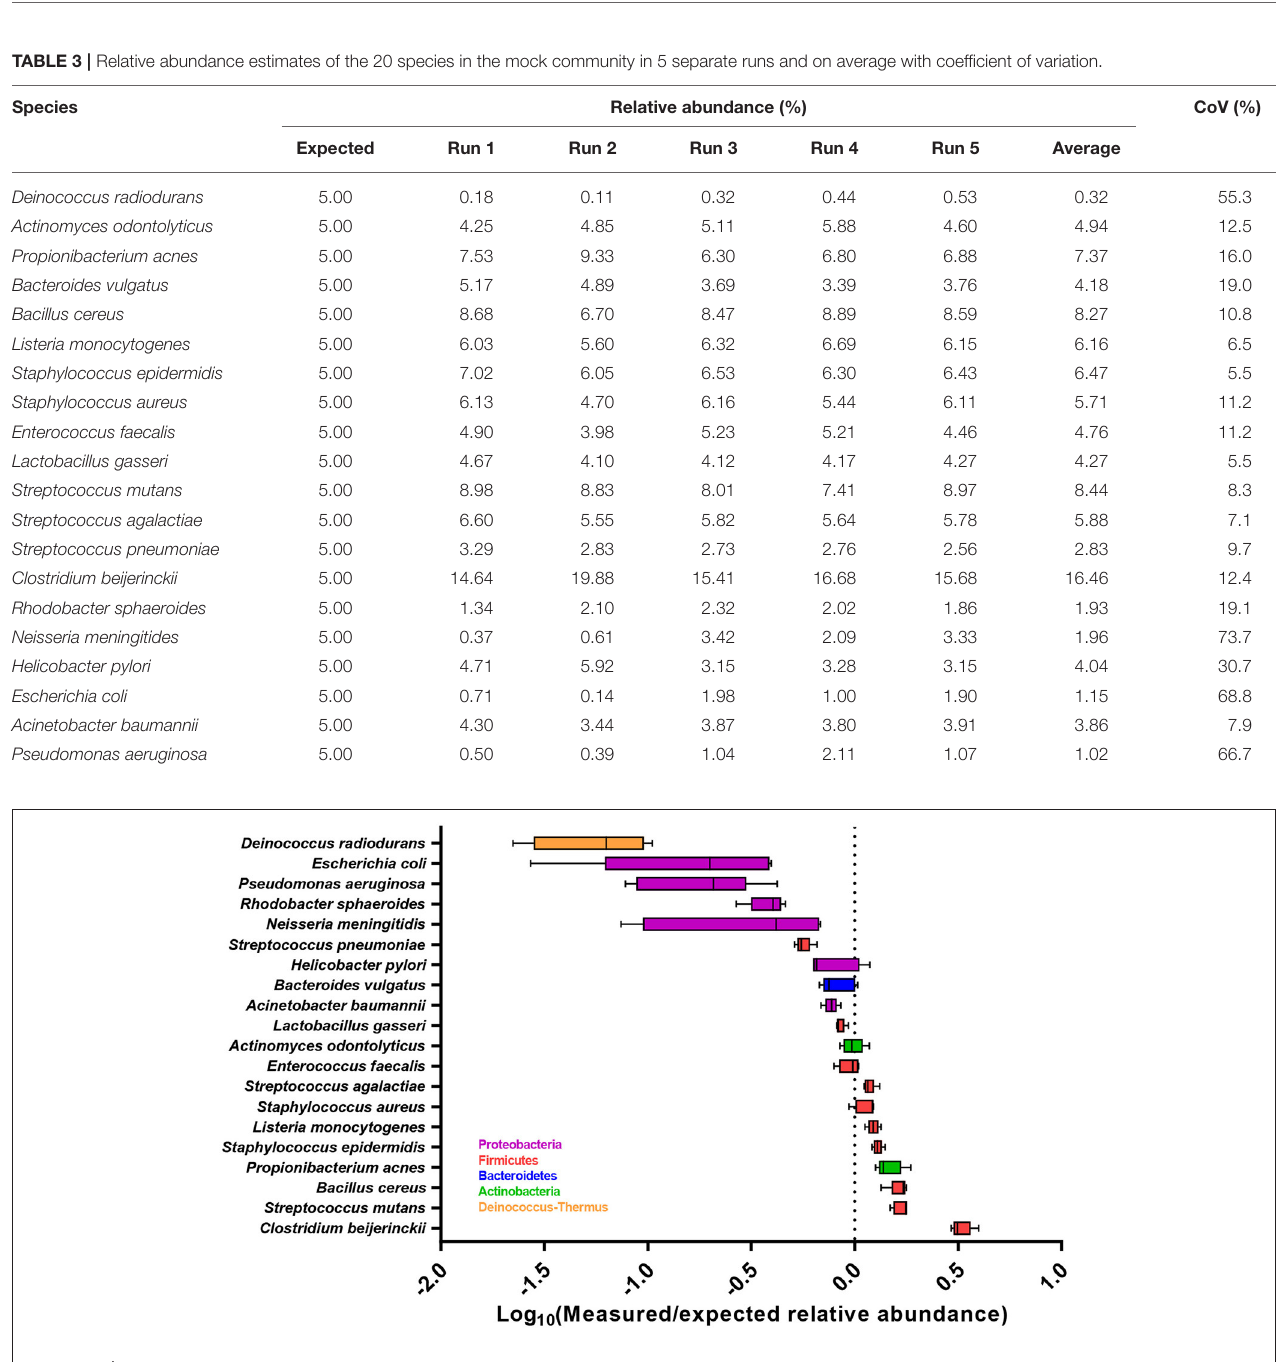
FIGURE 2 | Accuracy of the abundance estimates across all five sequencing runs for each bacterial species, expressed as the Log 10 ratio of measured relative abundance to the expected relative abundance. Boxplot show the median with 25 and 75 percentiles within the box and whiskers show the range. Dashed line indicates the expected relative abundance of